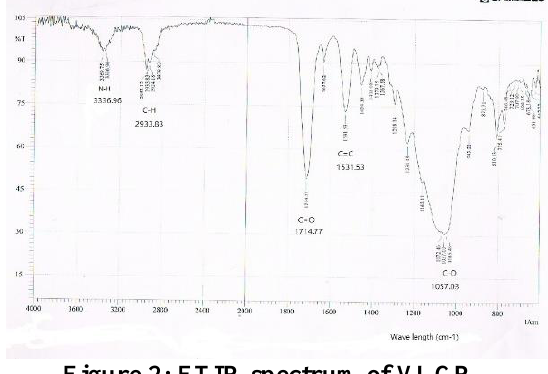
Figure 2: FTIR spectrum of VLCR.